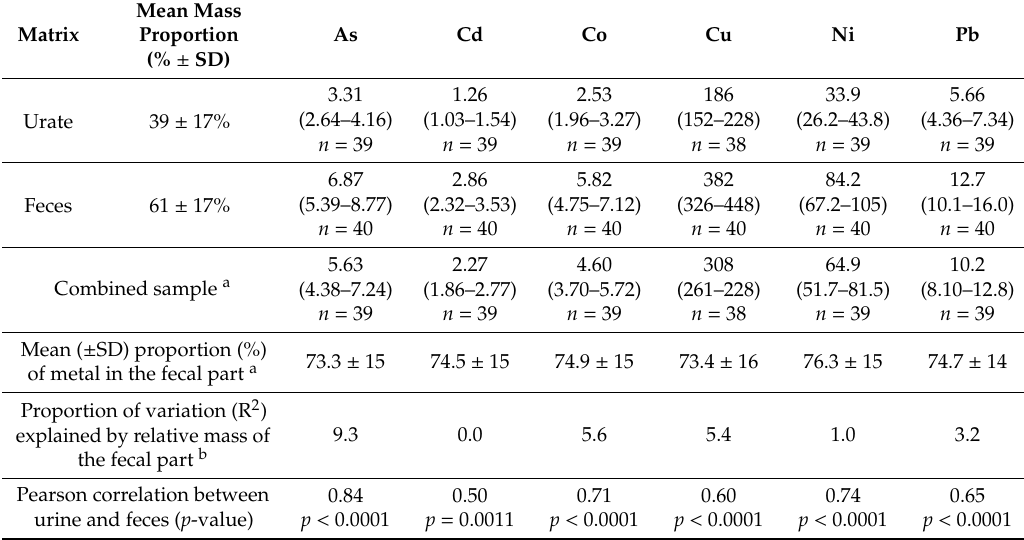
Table 4. Geometric means ( ± 95% confidence limits) for metal concentrations ( µ g / g, d.m.) in urate and feces of F. hypoleuca